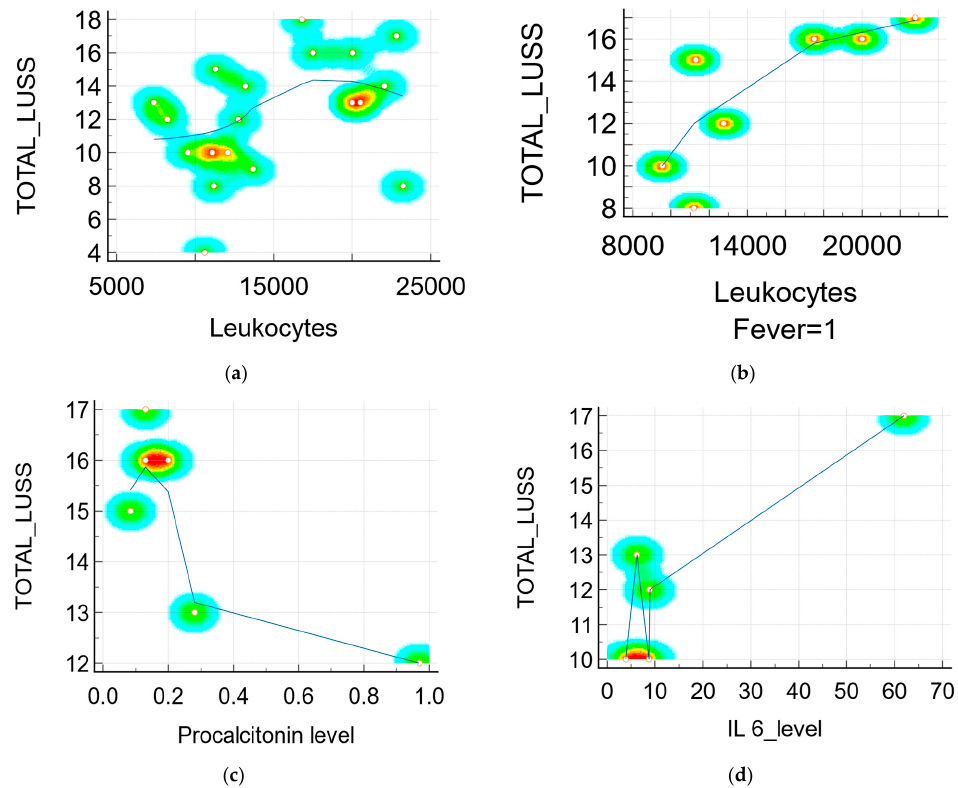
Figure 7. Scatter diagram with a heat map of correlation between LUSS and O 2 saturation. 4. Discussion The neonates included in the study developed an asymptomatic, mild, or moderate form, without the need for orotracheal intubation due to SARS-CoV 2 infection. In accordance with Musolino et al. and Smargiassi et al., the importance of LUS is demonstrated in differentiating mild and moderate forms of COVID-19 pneumonia in children, due to the fact that children with mild forms mostly have a normal LUS pattern with no pathological findings [23,24]. The severity of the admitted cases has been reduced when compared to other similar studies that describe the need for intubation and even death among newborns with COVID-19 pneumonia [25]. This fact is also confirmed by our study results: a higher mean birth weight (2936.84 g vs. 2394 g), the percentage of preterm births was lower (10.52% vs. 41%), the mean of APGAR score was